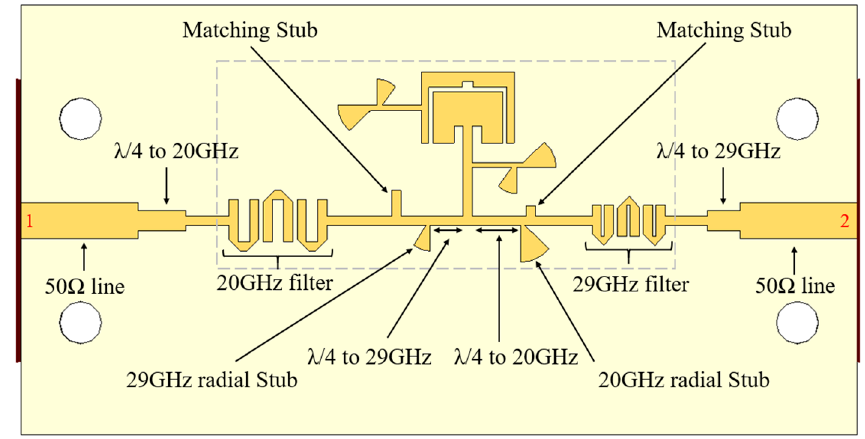
Figure 9. Complete structure of the designed reconfigurable filtenna (dual-band antenna and feeding arrangement with filters).